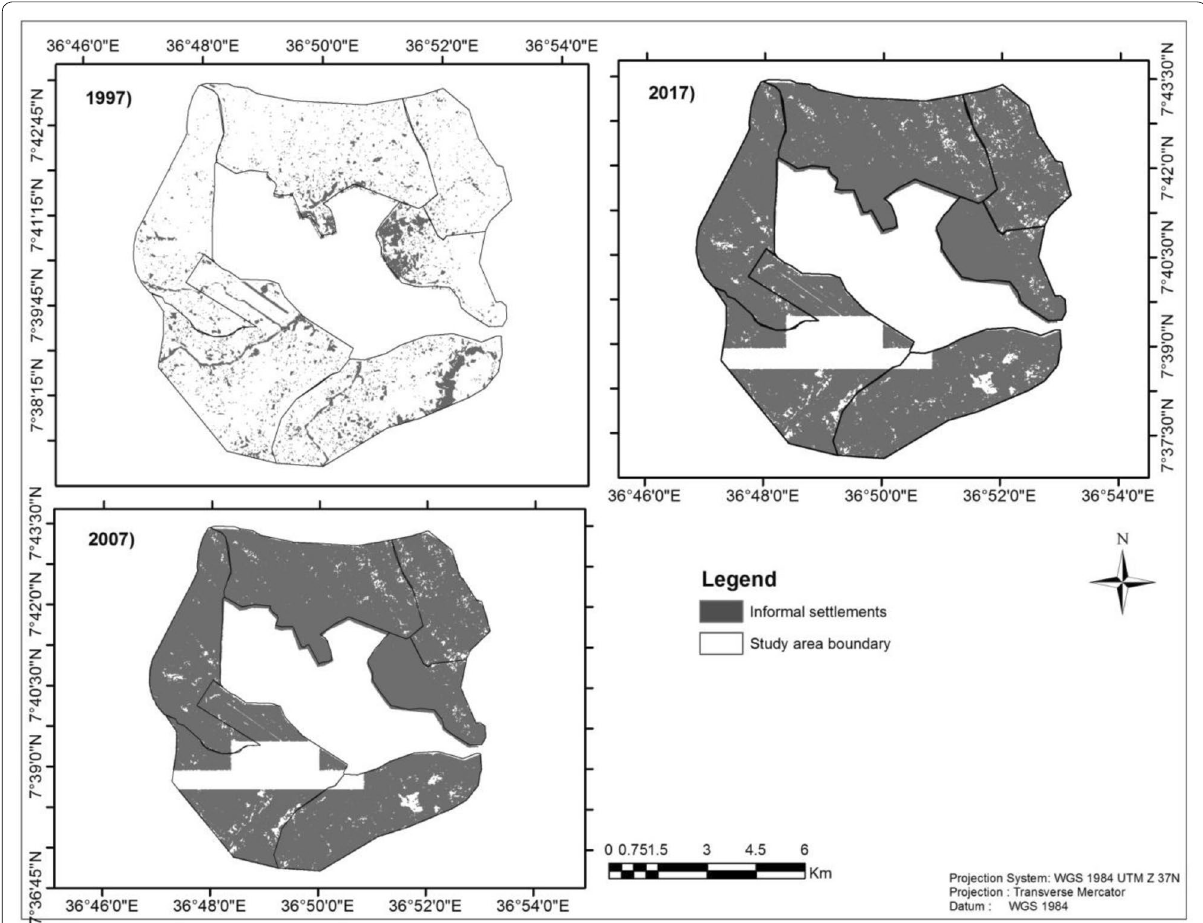
Fig. 5 Informal Settlement Map of Jimma city in 1997, 2007, and